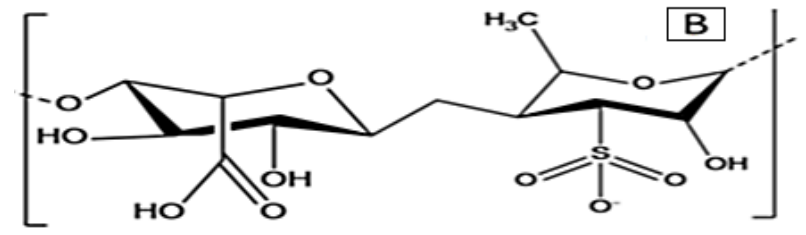
Figure 3. Ulvan chemical structure—B: iduronic acid and rhamnose 3-sulfate.